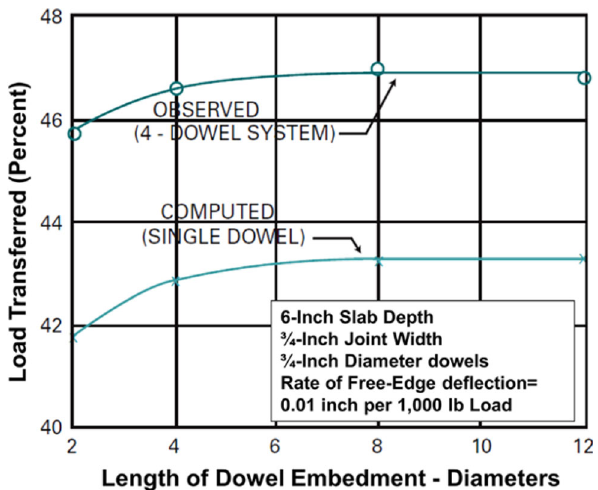
Fig. 1 Load transfer versus dowel embedment.